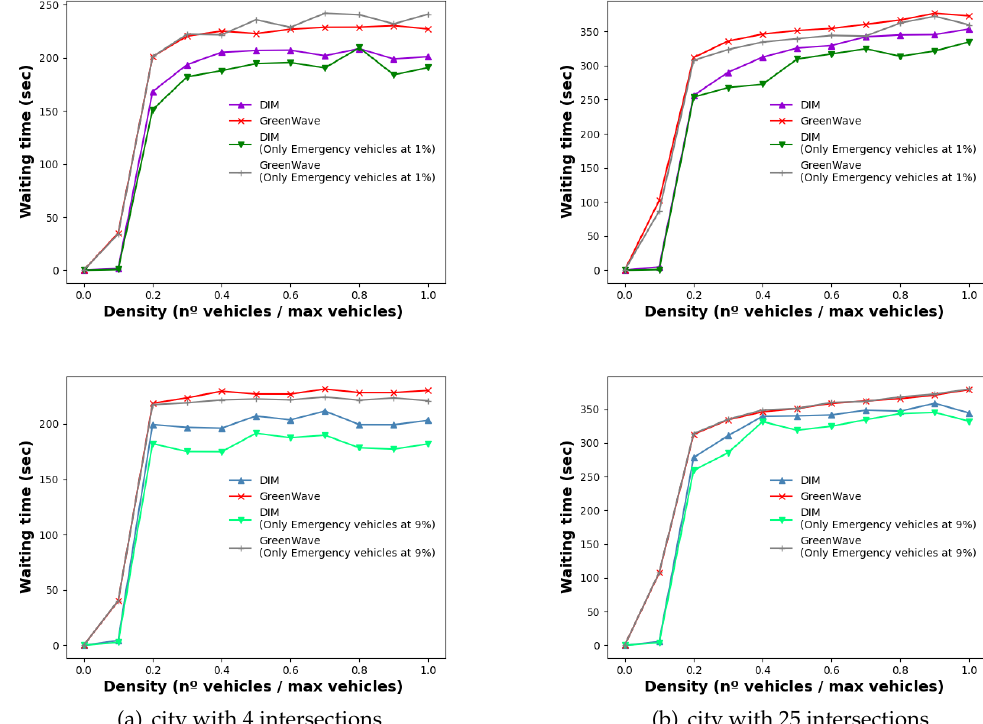
Figure 4. Models comparison with emergency vehicles at 1% ( top ) and 9% ( bottom ) in two different cities.